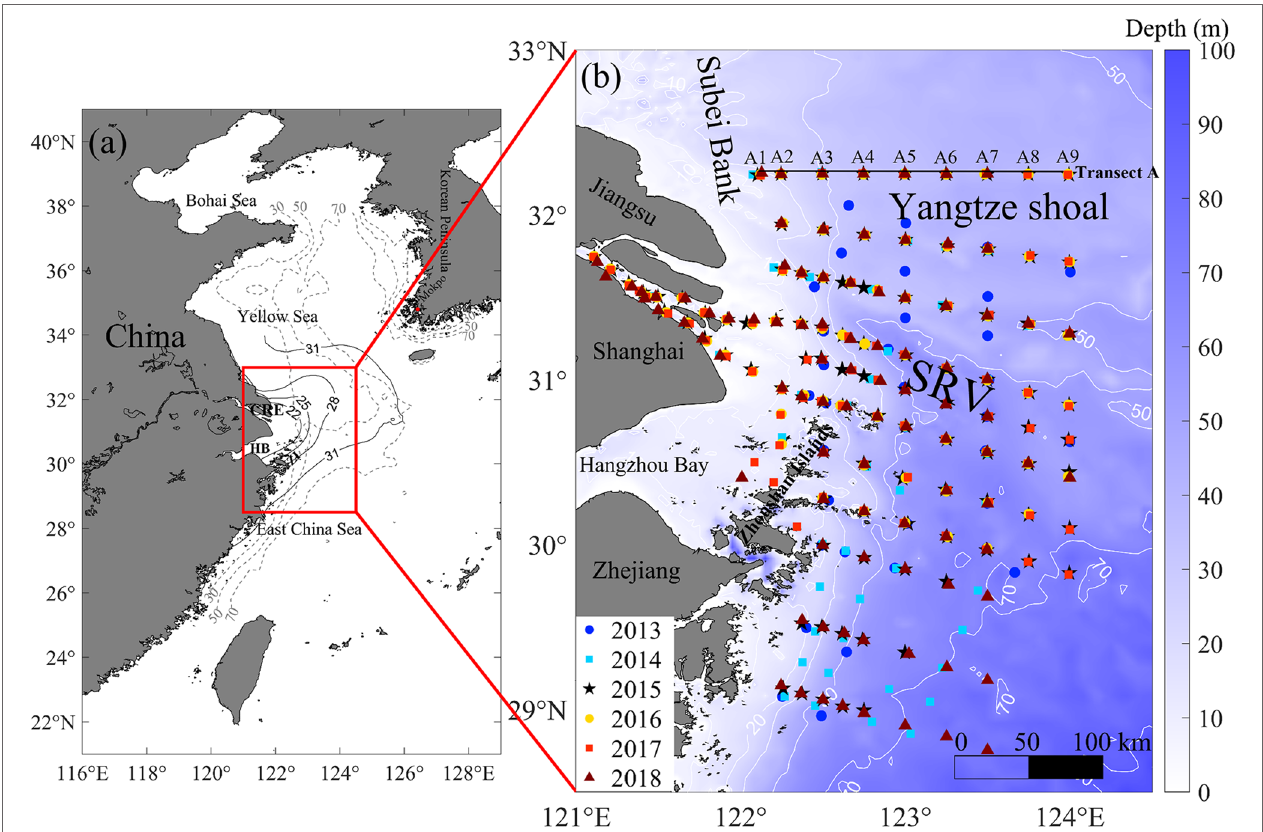
FIGURE 1 | The location of the Changjiang River Estuary (CRE), East China Sea, and adjacent regions (A) , and enlarged view of the CRE and adjacent shelf water zone including summer survey sites from 2013–2018 (B) . The black solid isolines are climatological summer sea surface salinity digitalized from Marine Atlas of Bohai Sea, Yellow Sea East China Sea (1992) . The grey dashed lines represent water depths of 30 m, 50 m, and 70 m, respectively. SRV, Submerged River Valley; HB, Hangzhou Bay. The transect A1 was investigated from Jiangsu coastal region (site A1) to Yangtze Shoal (site